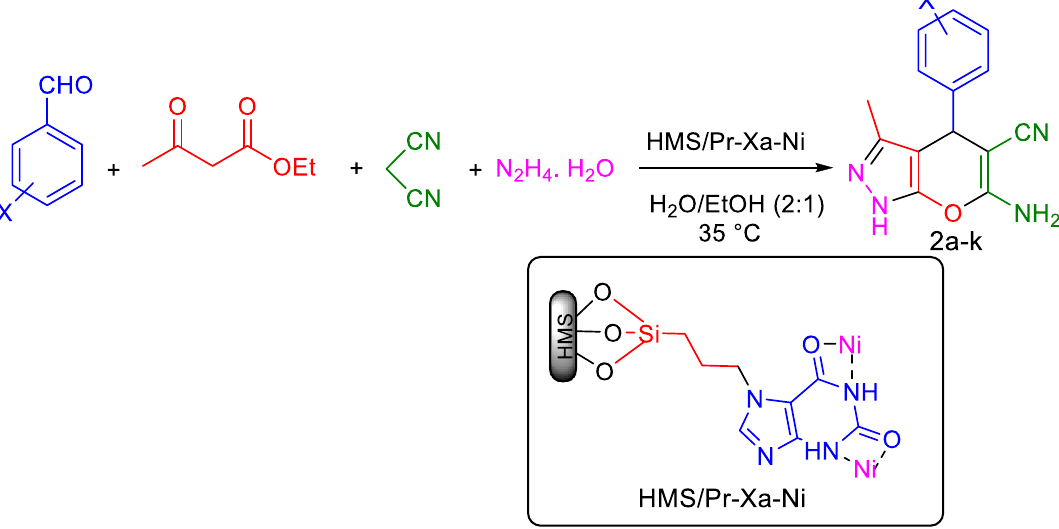
Figure 21. General procedure for the synthesis of 1,4-dihydropyrano[2,3-c]pyrazole.